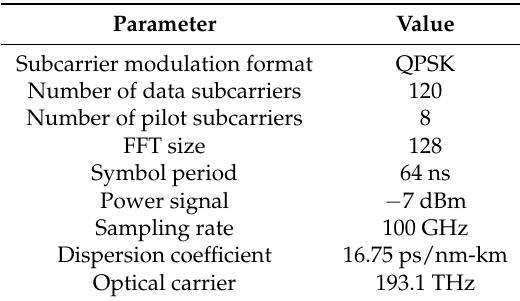
Table 1. Simulation